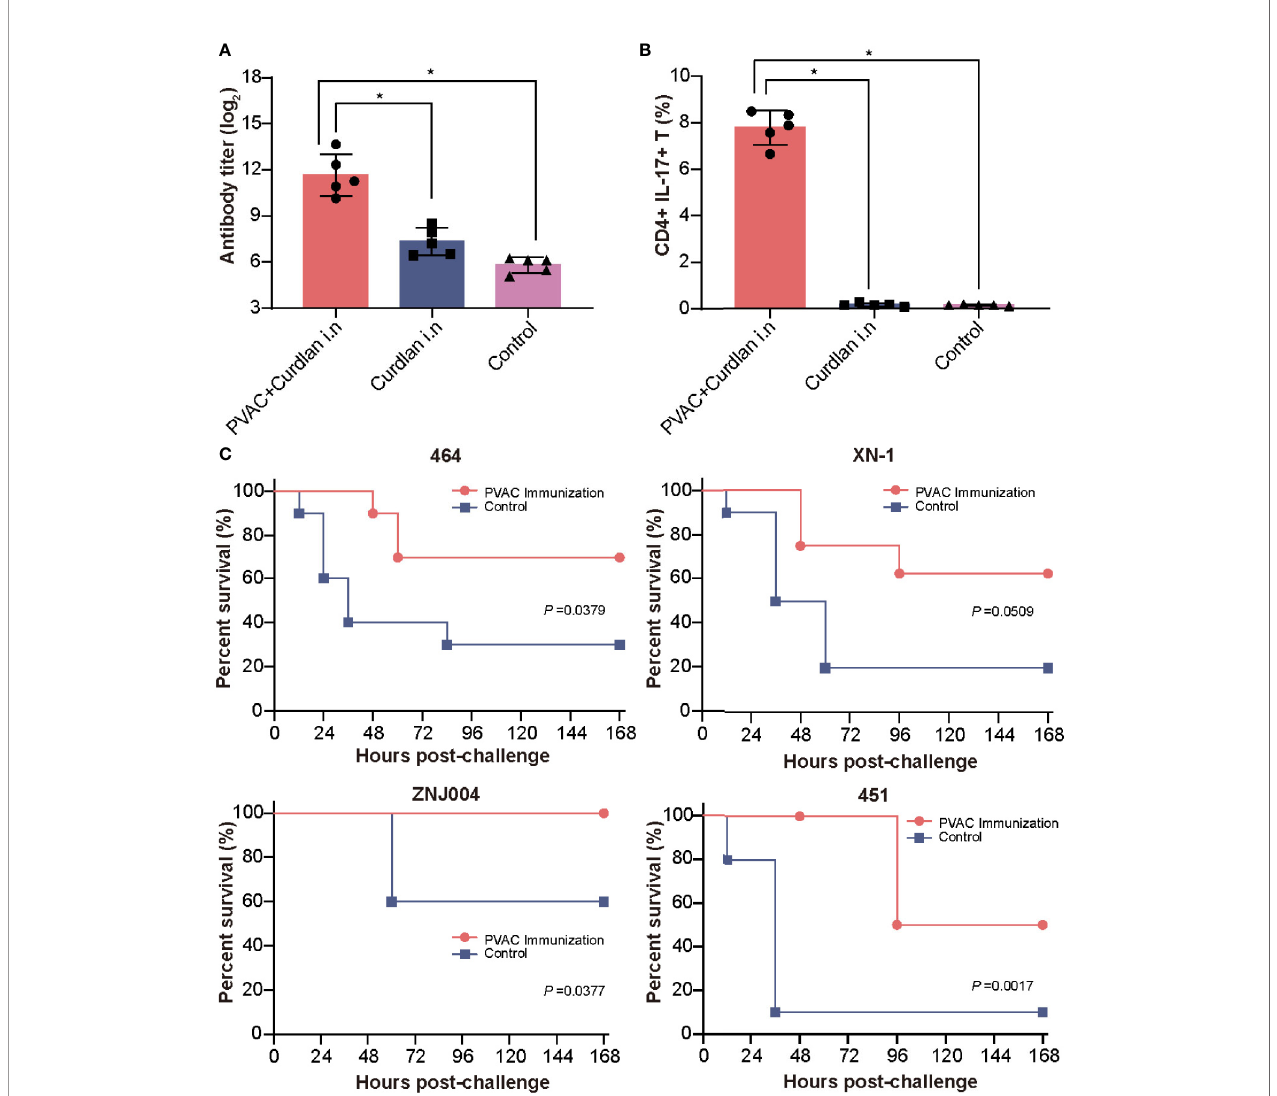
FIGURE 6 | Vaccination with PVAC protects against PA strains of four different serotypes. (A) PVAC, which is composed of the N-terminus of rePcrV (27Glu- 126Gly) connected to full-length reAmpC, was produced and used to immunize mice. The bar represents the titer of anti-PVAC IgG in the serum of immunized mice (n = 5) (B) The bar represents the frequency of CD4 + CD17 + T cells in the lungs of immunized mice. (C) PVAC-immunized mice were challenged via intratracheal injection of PA-464, PA XN-18 PA ZNJ004, and PA-451. The survival rates of the four immunized groups were signi fi cantly higher than that of the control group. The “ * ” indicates a signi fi cant difference at P <